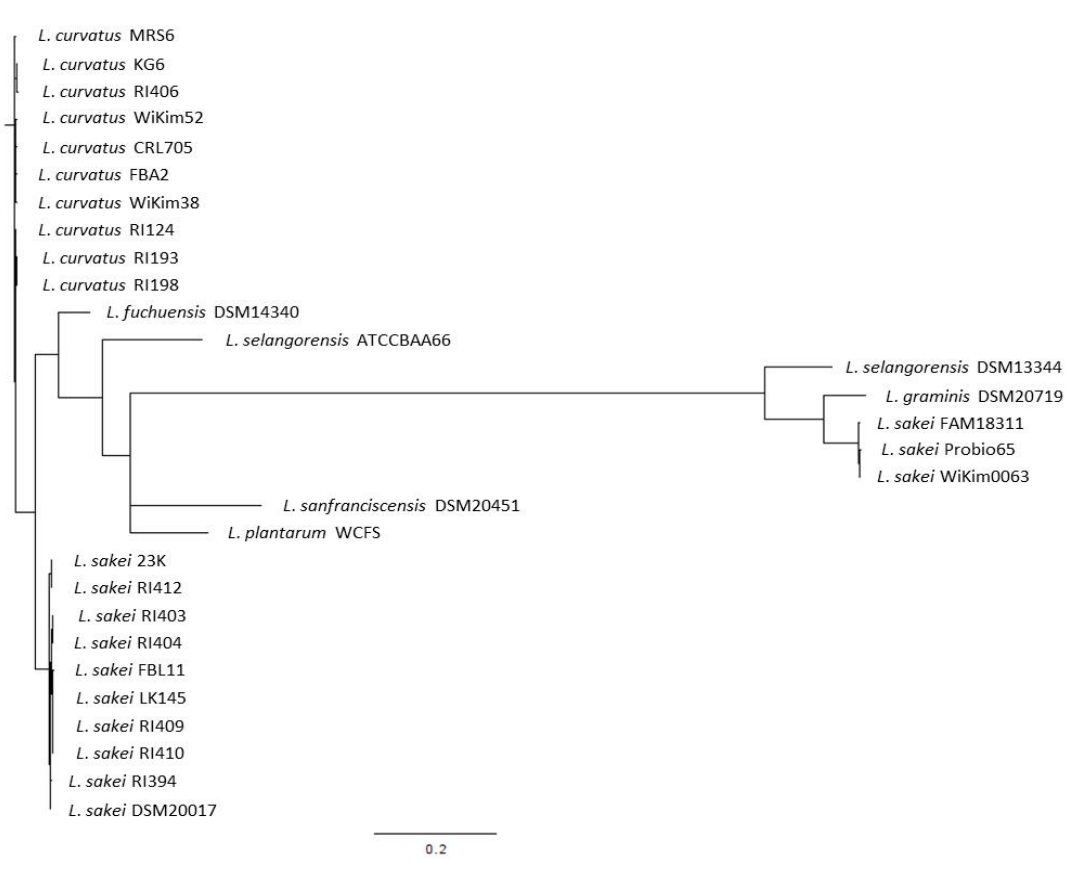
Figure 1. Phylogenetic tree drawn from the rpoB gene sequences of the main species belonging to the L. sakei clade.